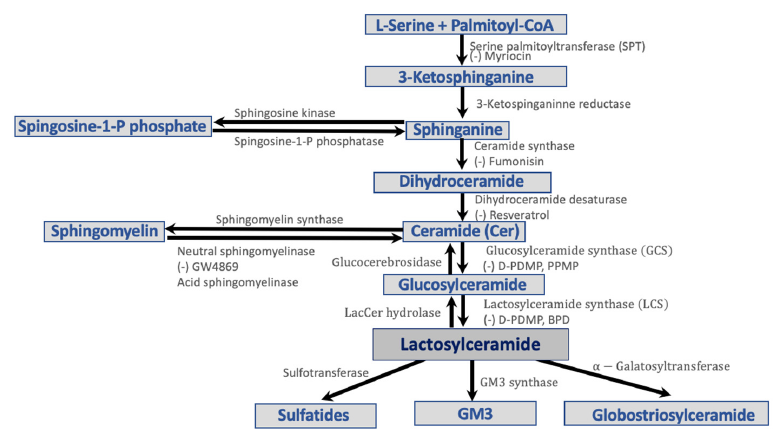
Figure 1. Pathways in the biosynthesis and catabolism of glycosphingolipids and sphingolipid synthesis inhibitors.